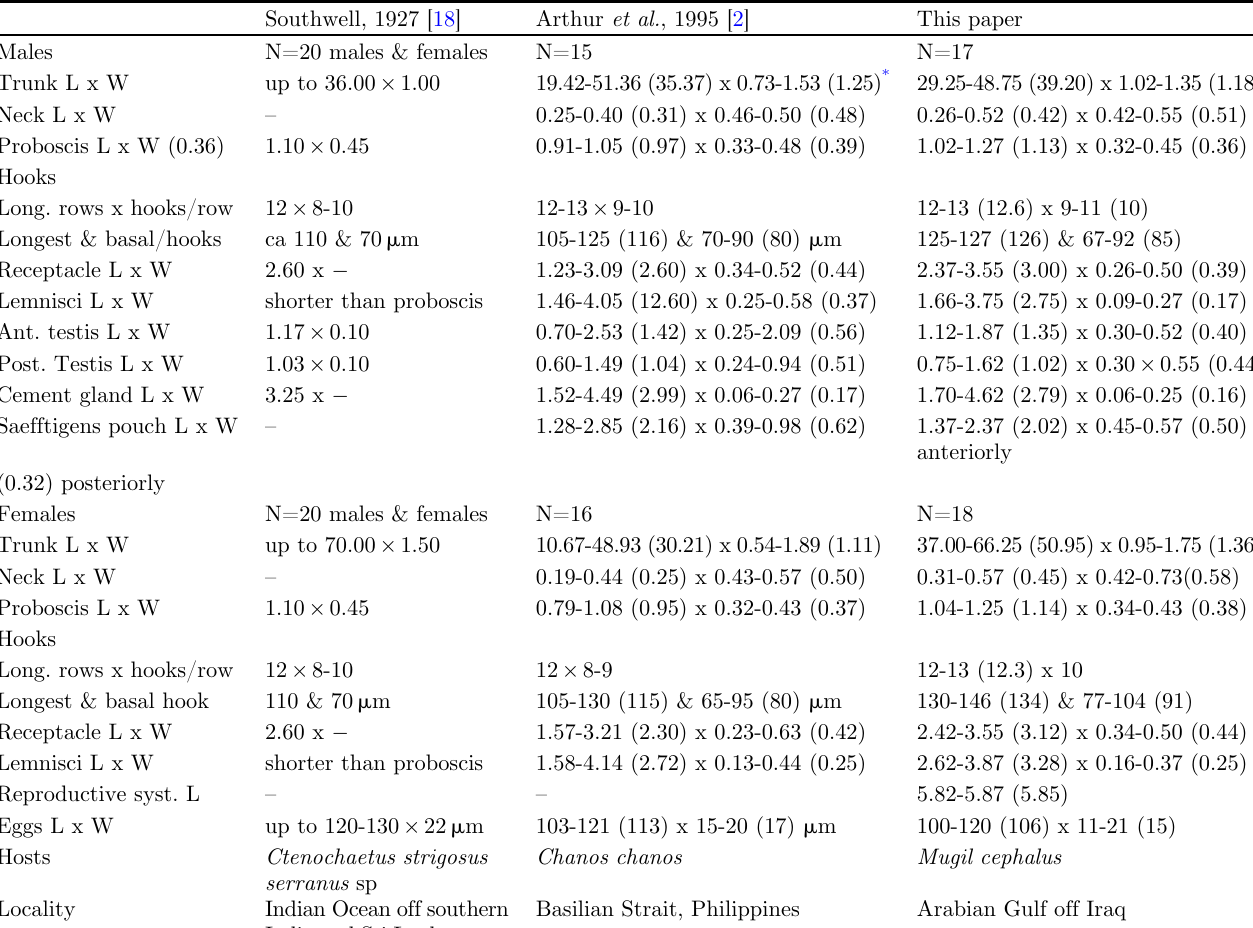
Table 1. A comparison of morphometric accounts of Cavisoma magnum.